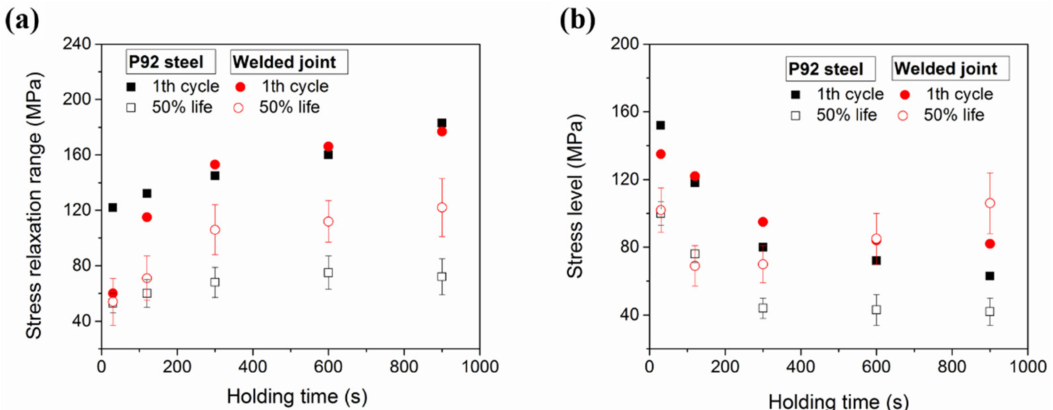
Figure 9. ( a ) Stress relaxation range and ( b ) stress level of all the welded and BM specimens at the 1st cycle and 50% of the lifetime